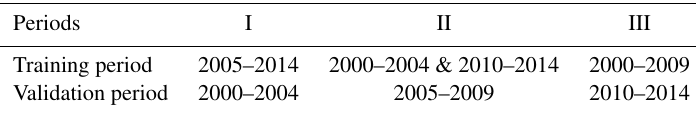
Figure 2. The W3 model simulated mean river discharges ( > 100m 3 s − 1 ) in the Amazon Basin (grey line: basin boundary; brown dot: gauging station). Table 2. Training and validation periods for the cross-validation method. Periods I